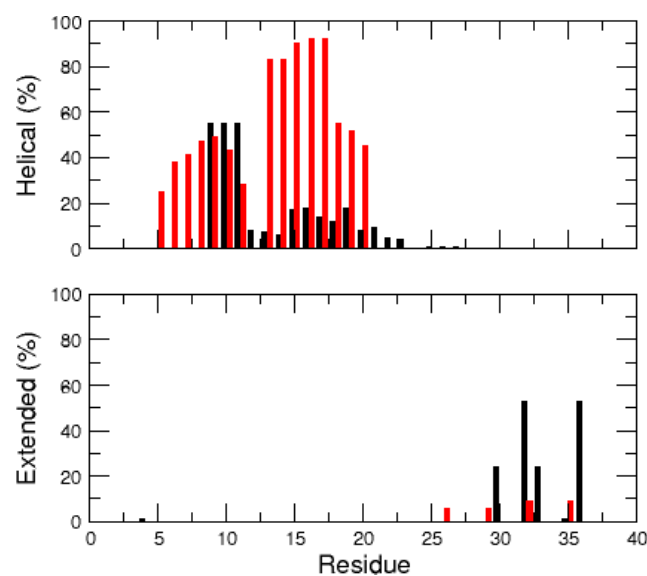
Figure 4. Secondary structure probability (%) of the amino acids of the amidated ( black bar) and non-amidated ( red bar) hIAPP monomer.